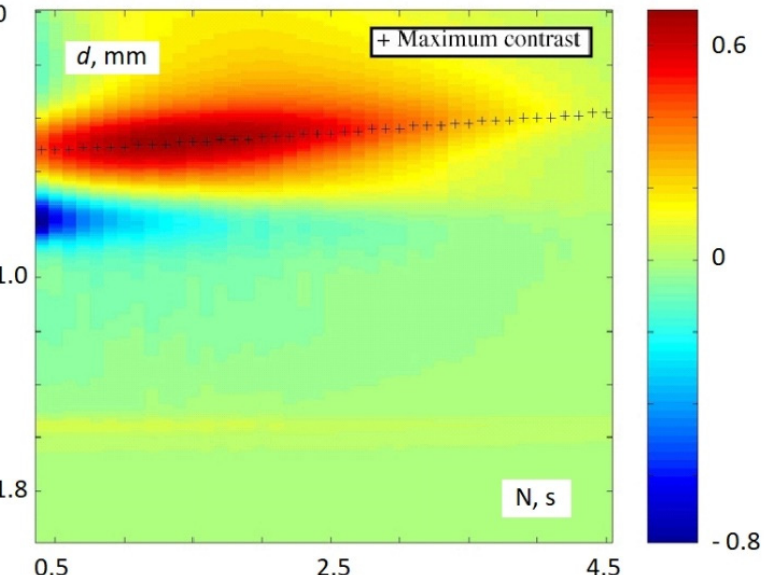
Figure 9. Wavelet shift factor N for which the defect location is best visible. Reprinted and adapted with permission from Ref. [53]. Copyright 1999, AITA.